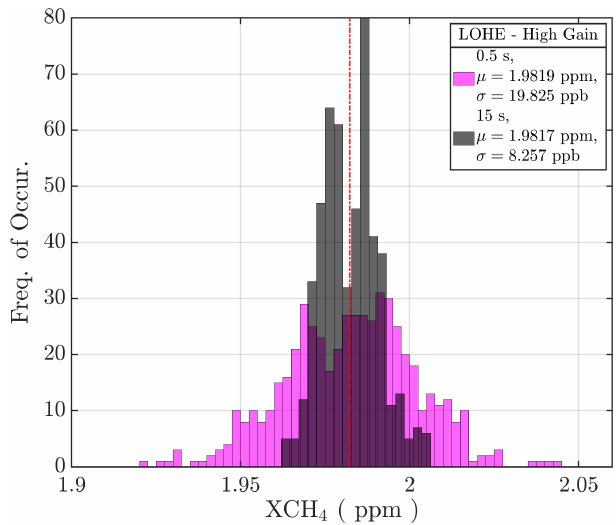
Figure 8. Histograms of the along-track XCH 4 retrievals, 30–40km from Fig. 7h. Raw 2Hz (0.5s) data are shown in comparison to a 15s average for the optimized high-gain signal. In each case the mean value and 1 σ SD are